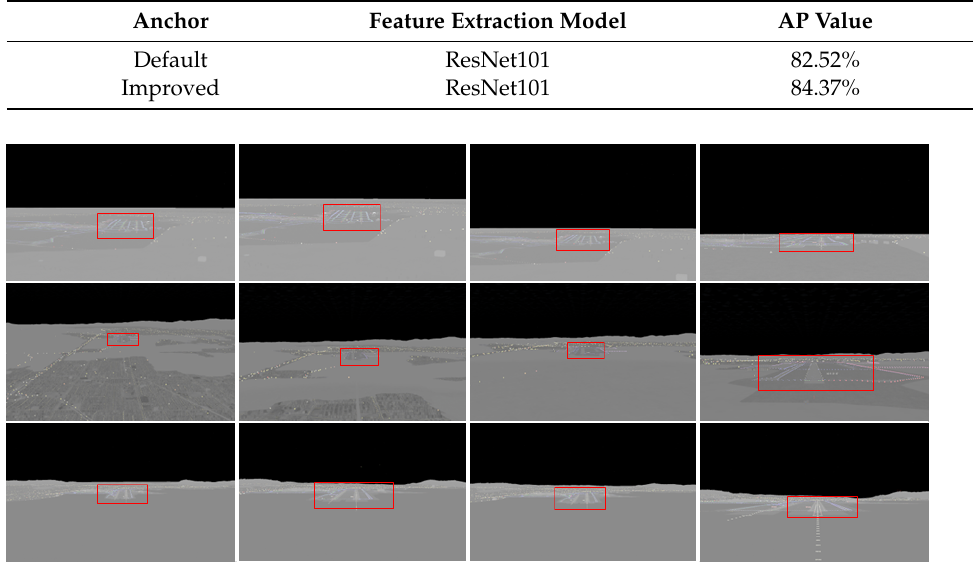
Table 4. Quantitative comparison of different anchor sizes.